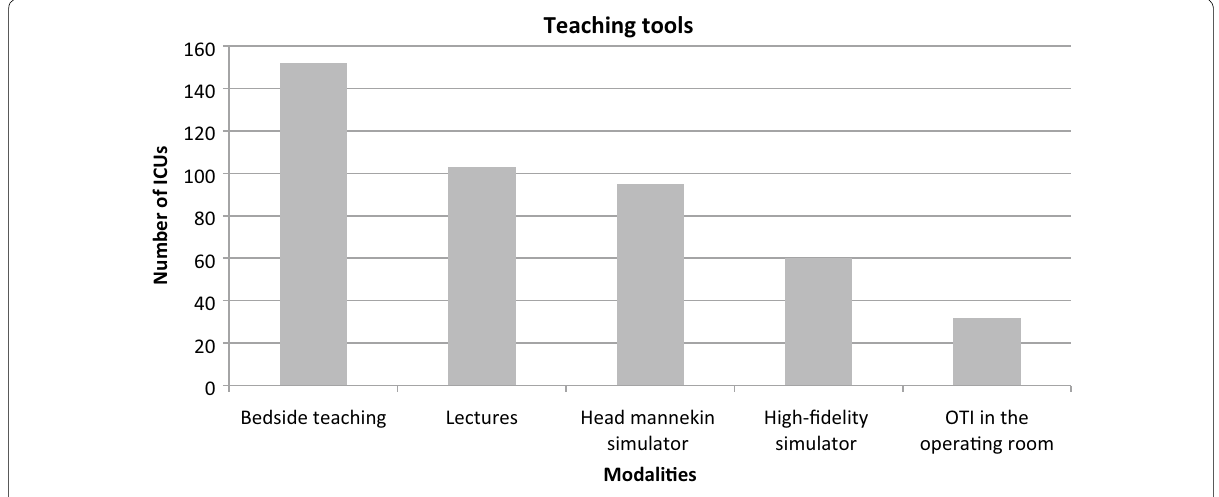
Fig. 2 Distribution of methods used to teach orotracheal intubation (OTI)